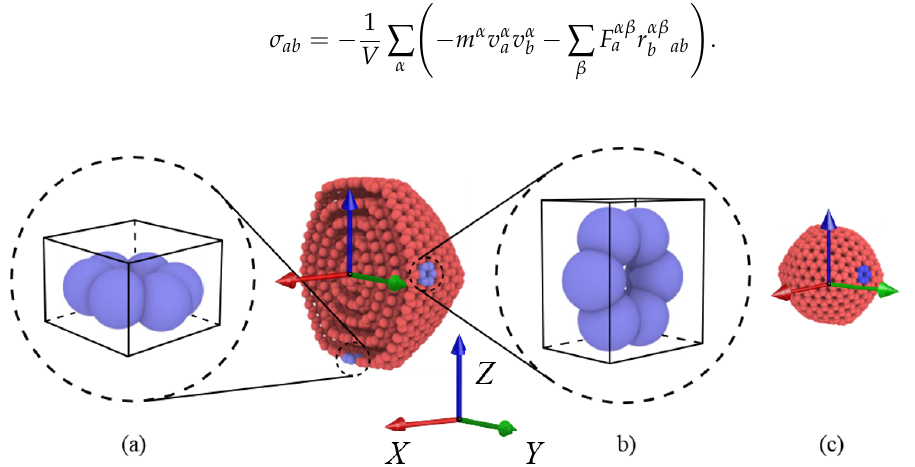
Figure 2. Two sets of carbon atoms are taken on the surface of five-layer multilayer fullerene ( a ) group 5L5Y ( b ) group 5L5(-Z). ( c ) A group of carbon atoms 5L3Y were taken from the surface of the three-layered fullerenes.